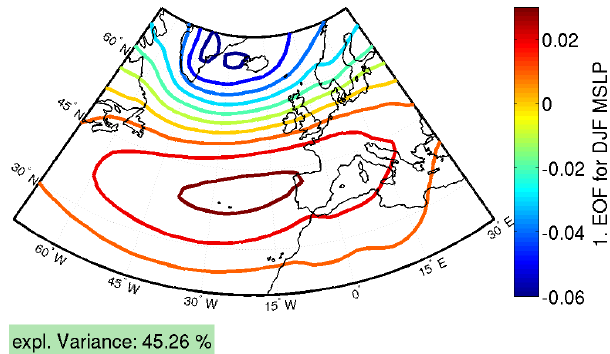
Figure 2. The NAO pattern exemplarily shown for ECHAM6 as the 1. EOF of mean-sea-level-pressure (MSLP). The corresponding principal components are used as the NAO index.